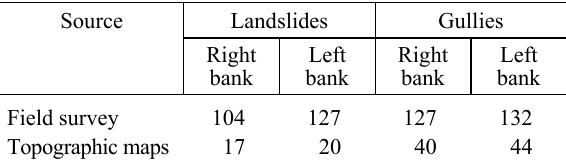
Table 1. Landslides and gullies identified from the topographic maps and during the field survey on the banks of the Gauja River Field survey 104 127 127 132